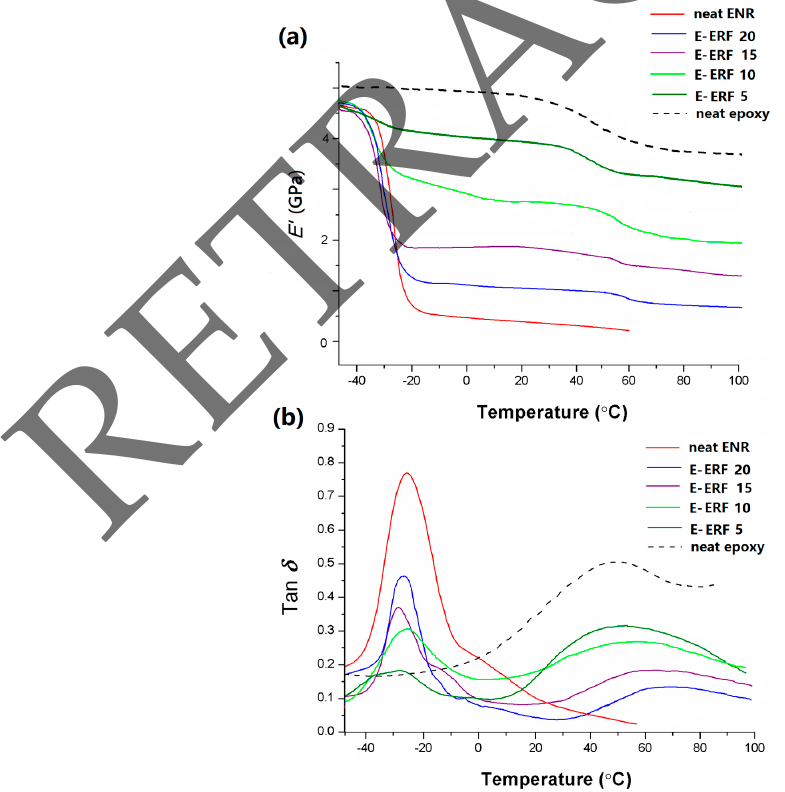
Figure 6. DMA plots of neat epoxy resin, neat ENR sheet, and E-ERF resins at different loading of ERFs in the temperature range of − 50 to 100 °C: ( a ) the storage modulus; and ( b ) the tan δ curves.